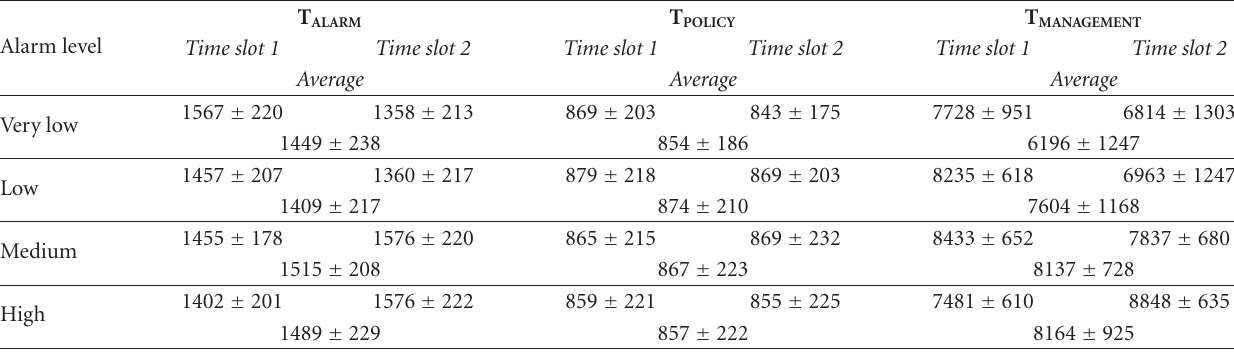
Table 2: Mean and standard deviation values of alarm detection ( T ALARM ), alert policy definition ( T POLICY ) and management, and overall alarm management times ( T MANAGEMENT ) in a basic Context Management